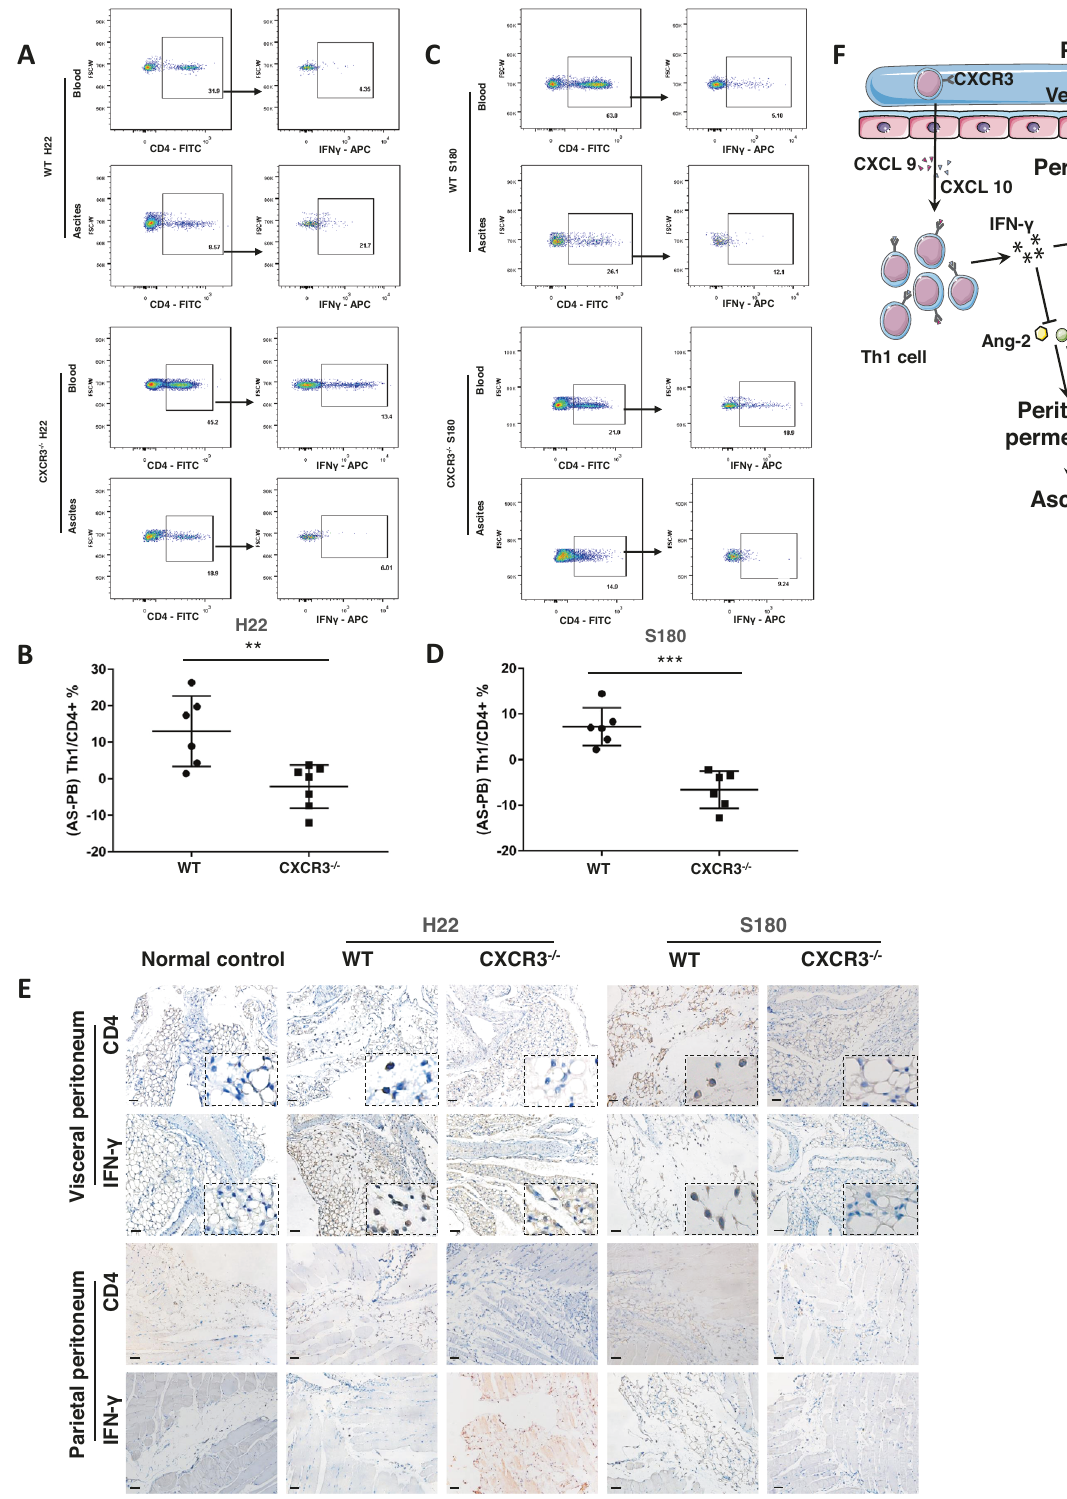
The effects of IFN- γ on the formation of malignant ascites and the growth of tumor cells in vivo Tumor cells (H22 cells and S180 cells) were injected intraperitoneally into IFN- γ − / − mice or wild-type (WT) mice; then the effects of IFN- γ on the